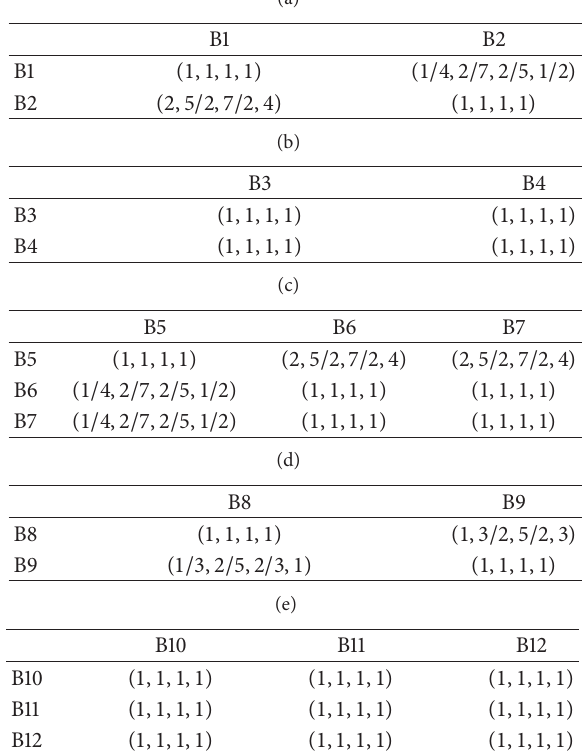
Table 7: Scale of relative importance used in the pairwise compari- son of AHP for 3-level